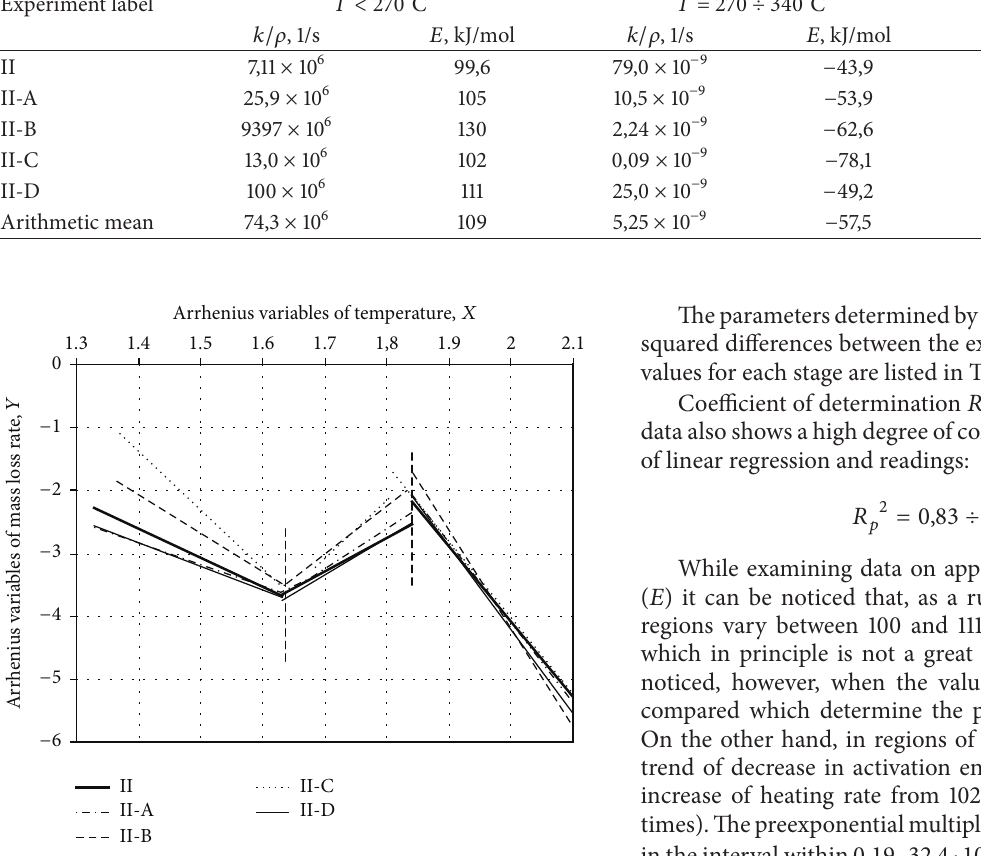
Figure 3: TGA of experiments around referent ones in Arrhenius